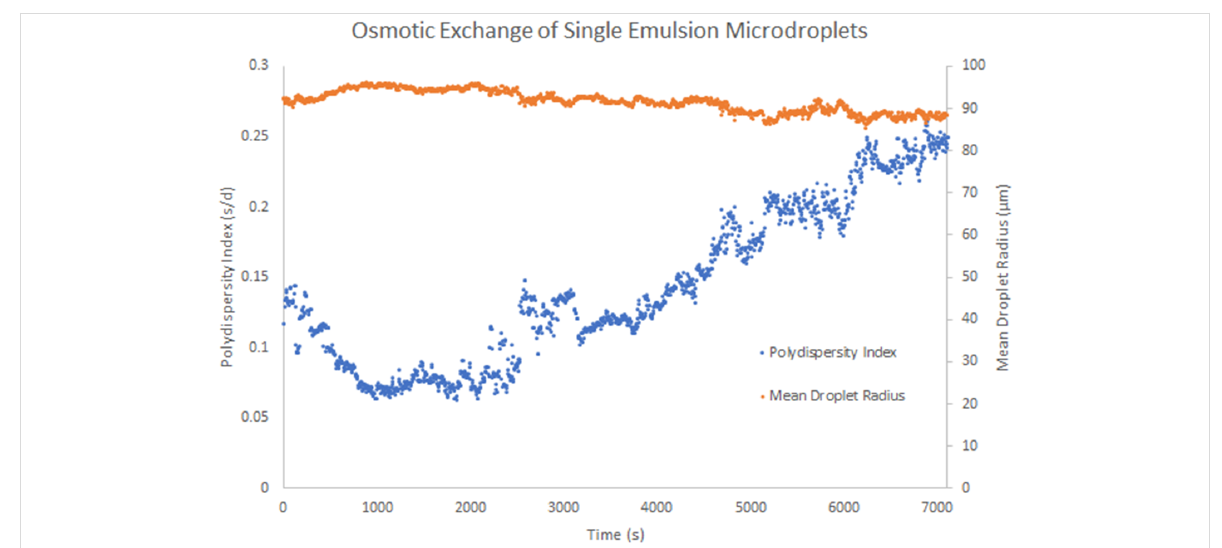
Figure 5: Real-time, LabVIEW TM tracking of osmosis-driven coarsening of 50 mM glycylglycine and pure water droplets. Increase in droplet polydis- persity is monitored using LabVIEW TM image analysis. s = standard deviation of droplet radius, d = mean radius.